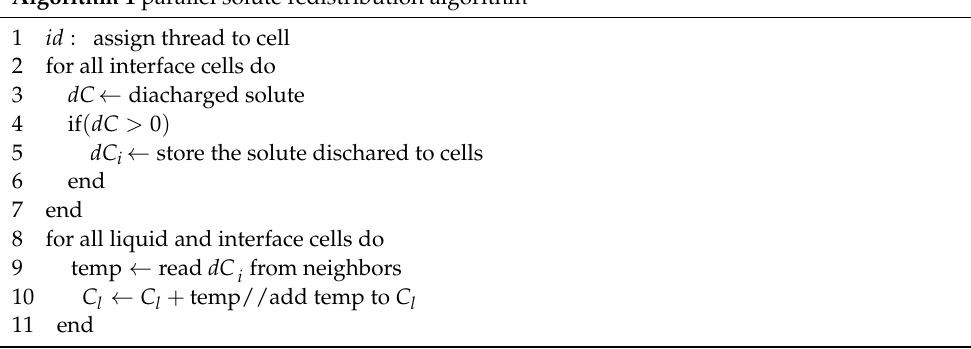
Algorithm 1 parallel solute redistribution algorithm